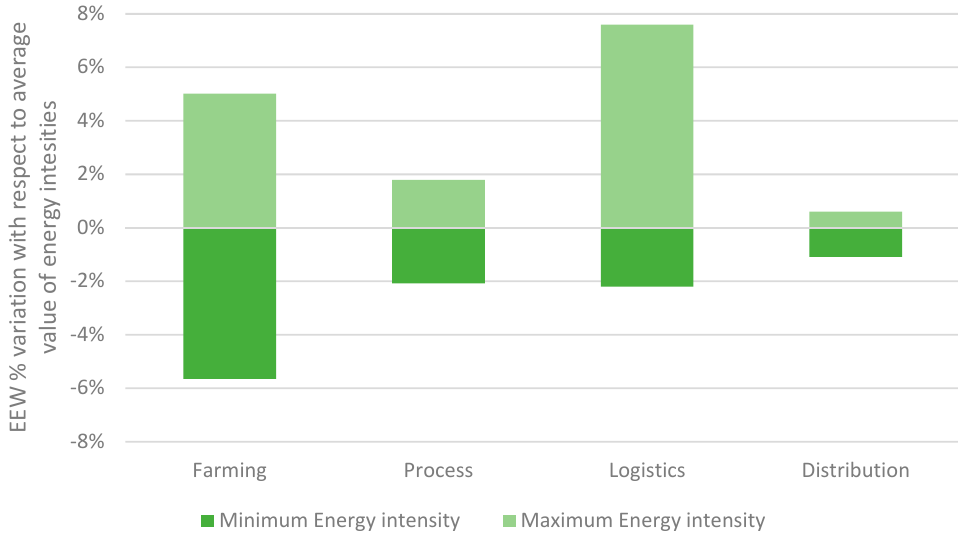
Figure 6. Percent variations in the total Embodied Energy Waste for year 2011 as a consequence of a variation in the Energy intensity parameters, as described from Sections 3.3.1 to 3.3.4.